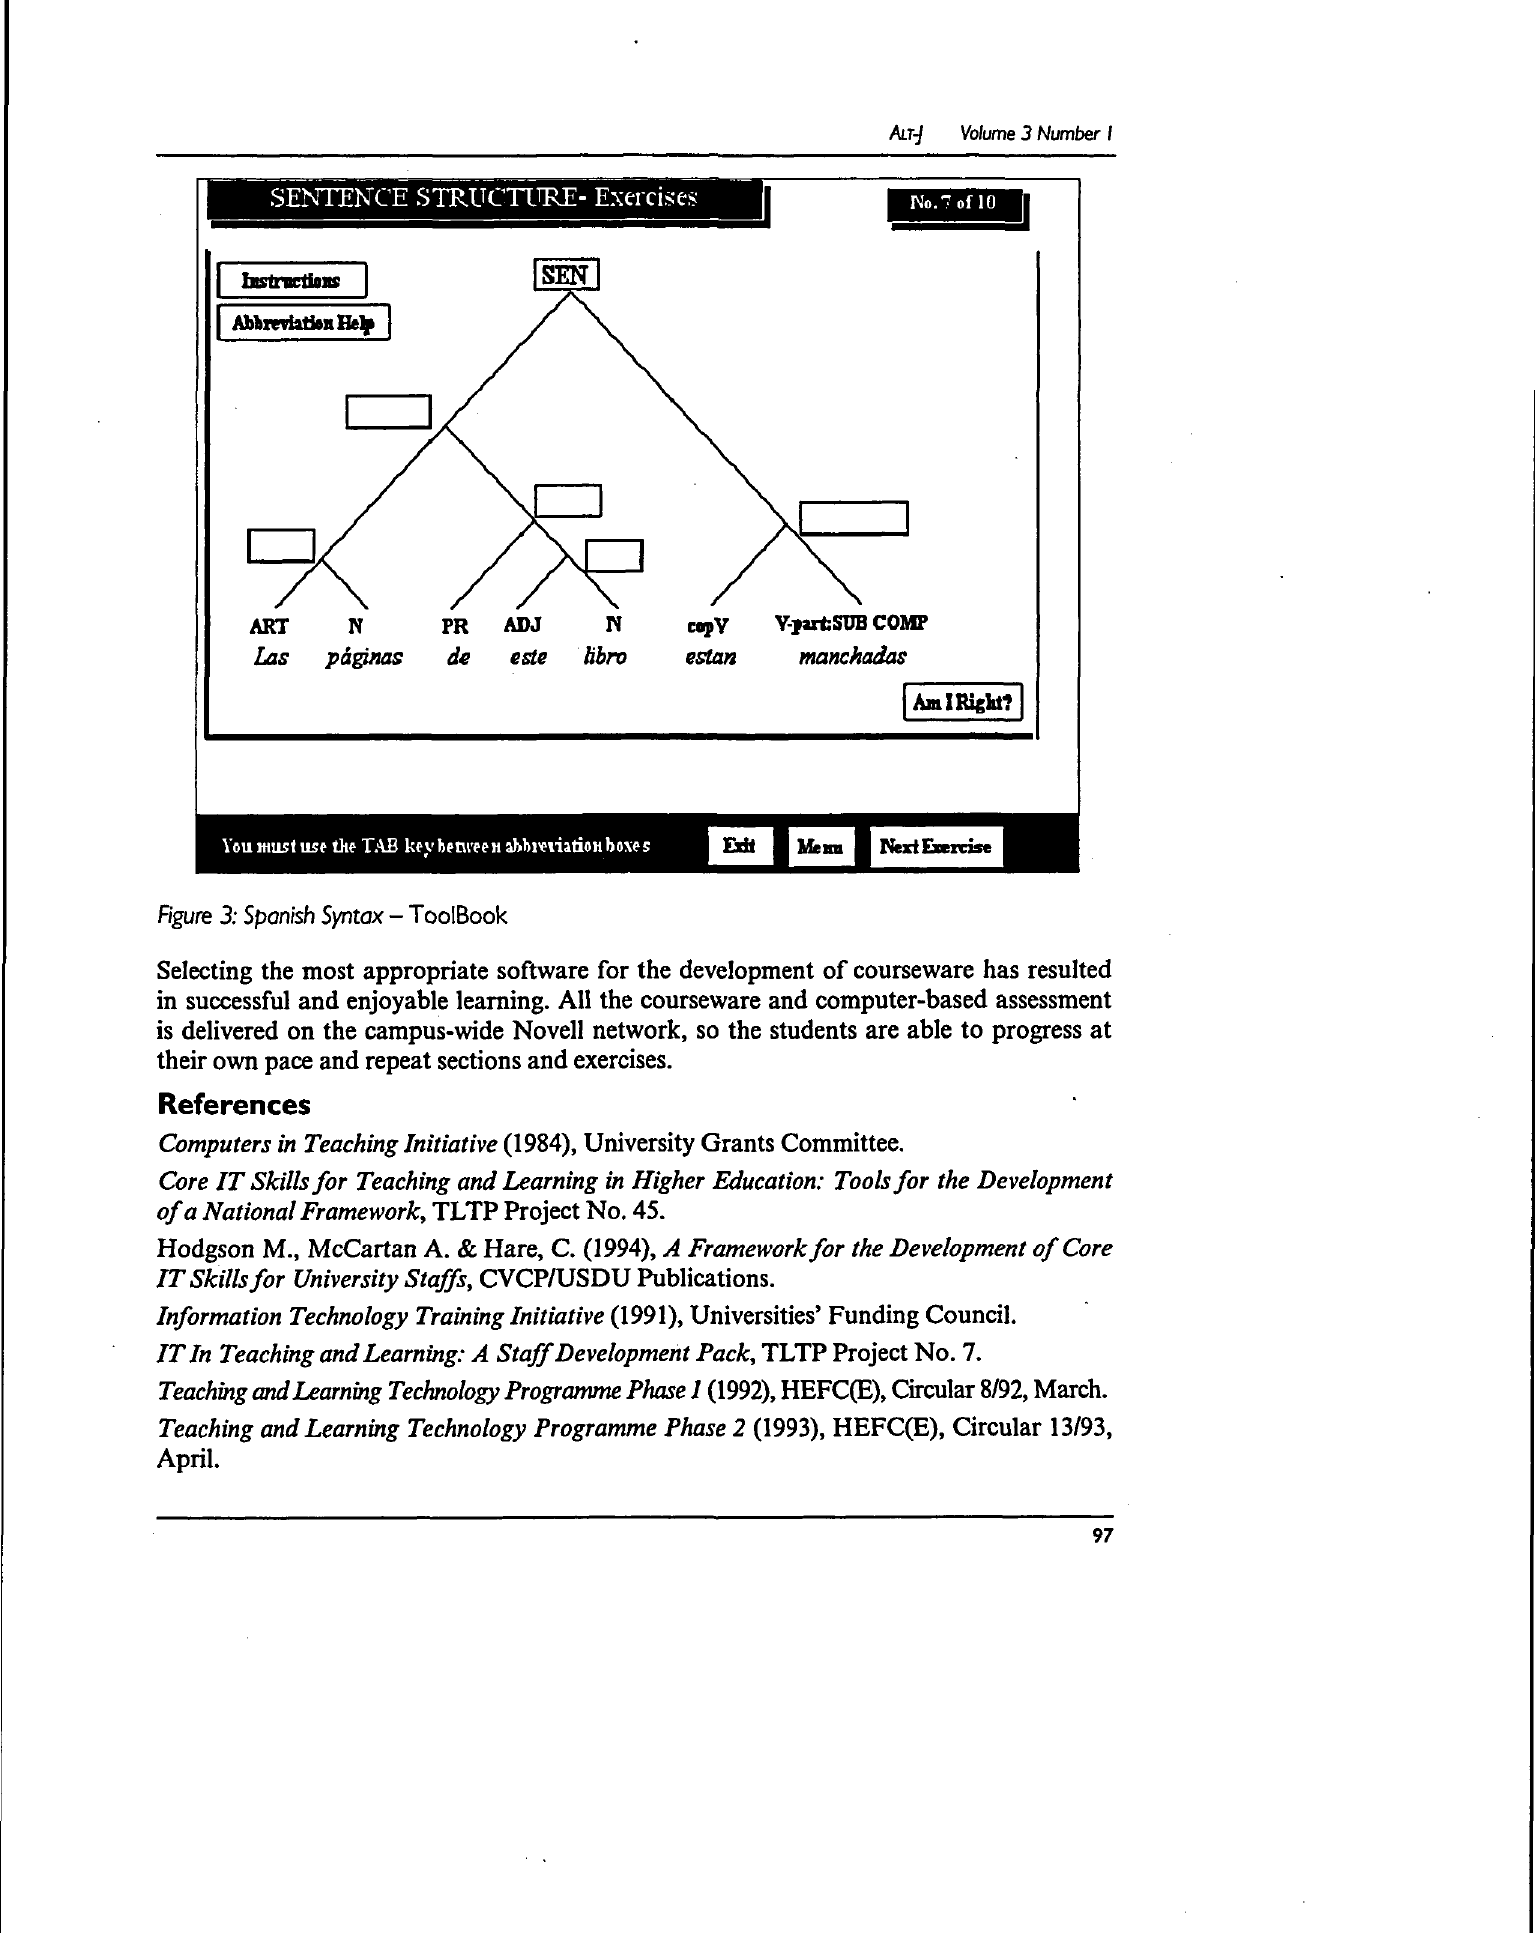
Figure 3: Spanish Syntax -